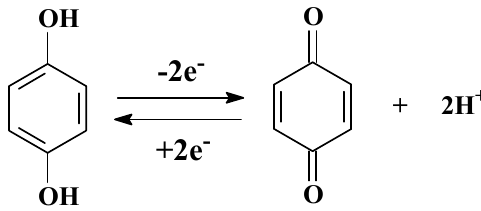
Figure 5. The redox reaction of quinone.